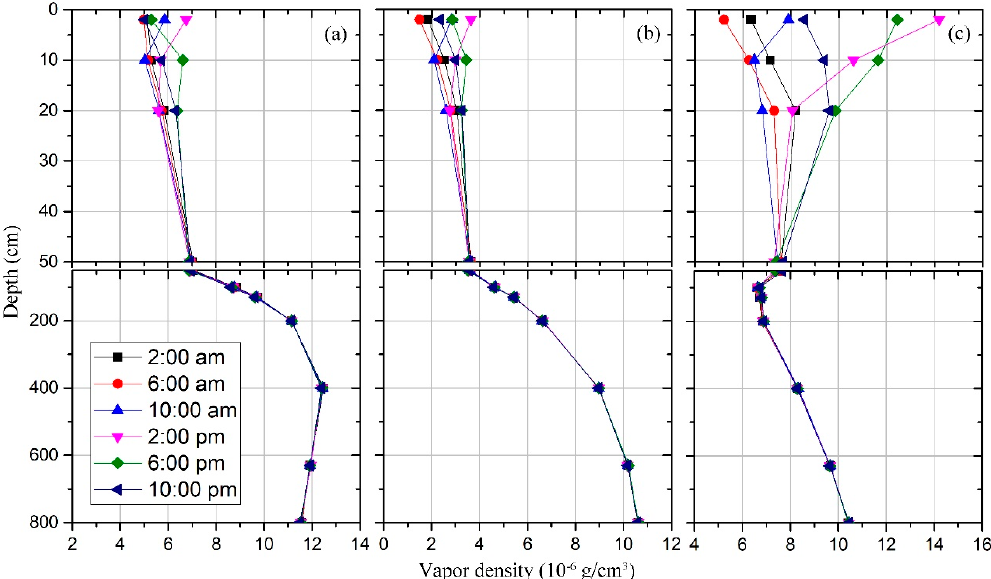
Figure8. Thedepthdistributionofthevapordensityondi ff erentdays: ( a )beforefreezing(16November), Figure 8. The depth distribution of the vapor density on different days: ( a ) before freezing (November ( b ) during the stable freezing stage (1 February), and ( c ) after melting (25 16), ( b ) during the stable freezing stage (February 1), and ( c ) after melting (March 25).